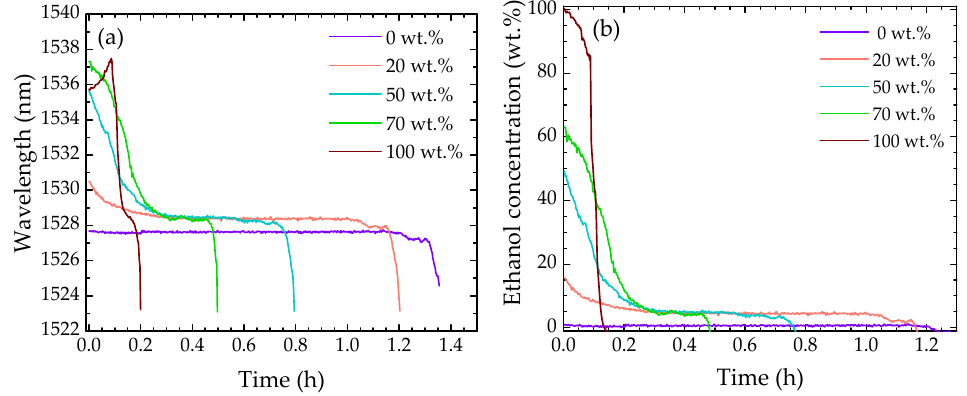
Figure 7. Temporal profiles of the ethanol–water mixtures with regards to ( a ) the wavelength variation and ( b ) the ethanol concentration.